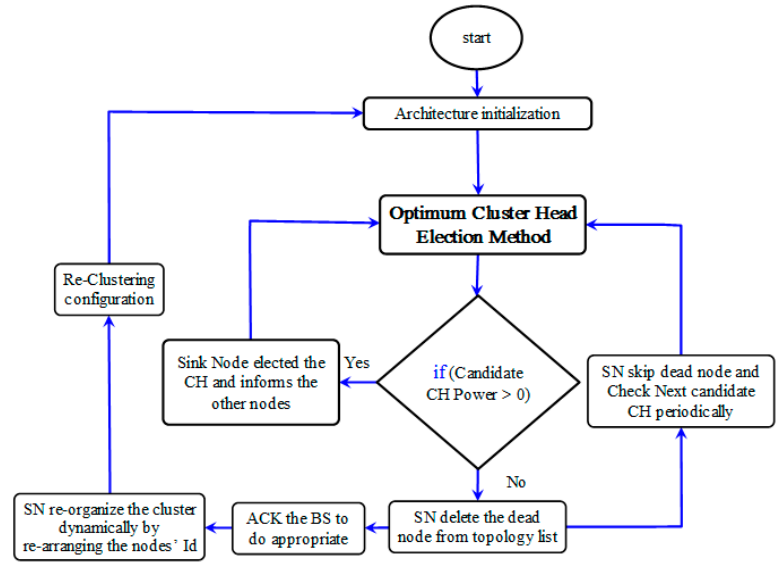
Figure 6. The proposed Dynamic Cluster Self-Organization Method’s data flow diagram.